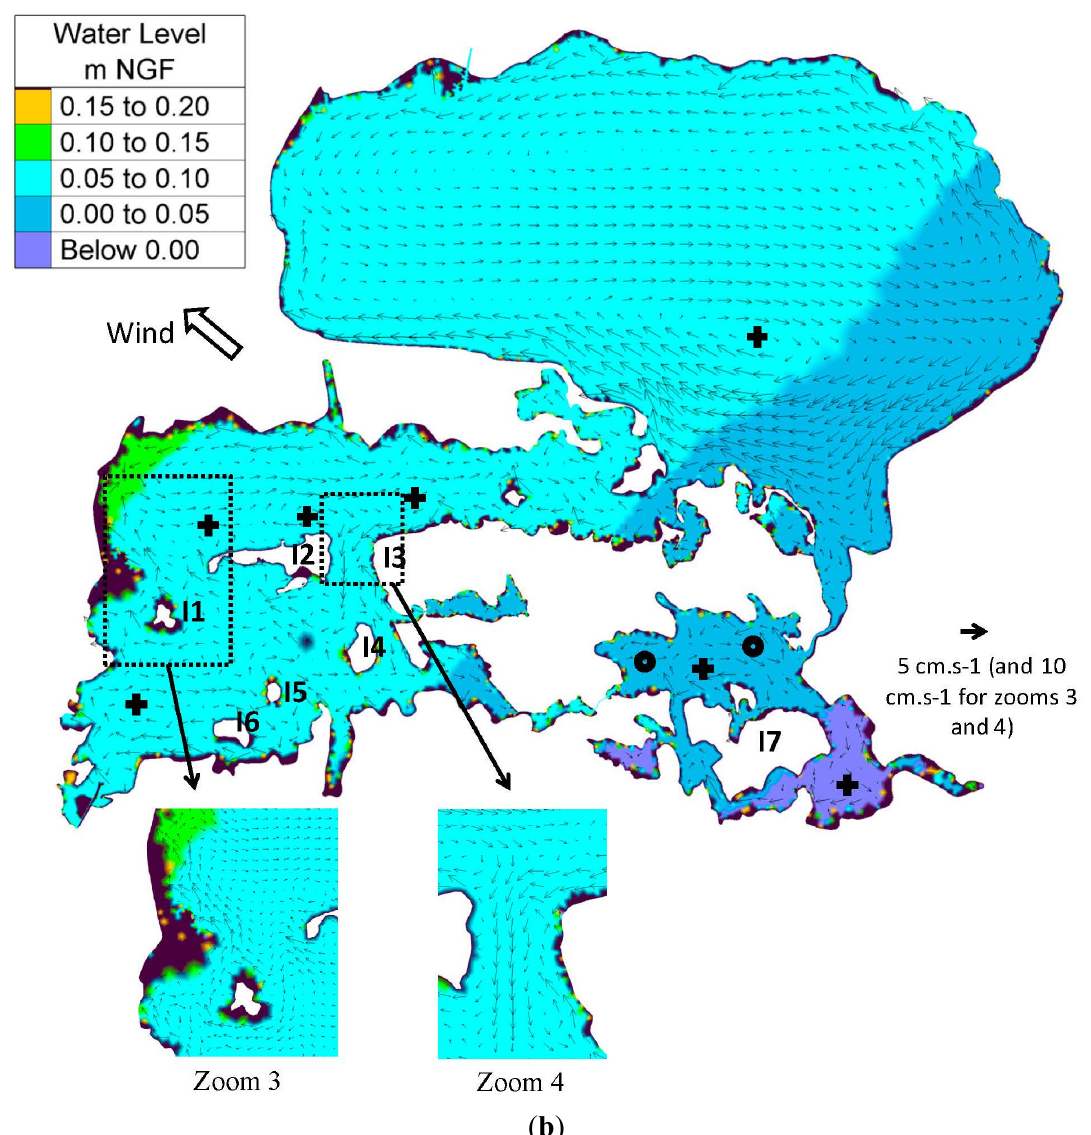
Figure 8. ( a ) Steady state circulations and water levels in the Vaccarès lagoon system due to a northwesterly wind (direction of 350° and speed of 7.59 m·s − 1 ); ( b ) Steady state circulations and water levels in the Vaccarès lagoon system due to a southeasterly wind (direction of 130° and speed of 6.45 m·s − 1 ). Direction is defined as the direction from which the wind is blowing. Circulatory gyres are shown in a schematic and simplified way, with crosses for anti-cyclonic rotation and circles for cyclonic rotation. Only the main gyres are represented. For the zooms 1–4, a finer spatial interpolation of the current field was performed, and the scale used for the vectors is twice as high compared to the rest of the figure. Areas in black are no water